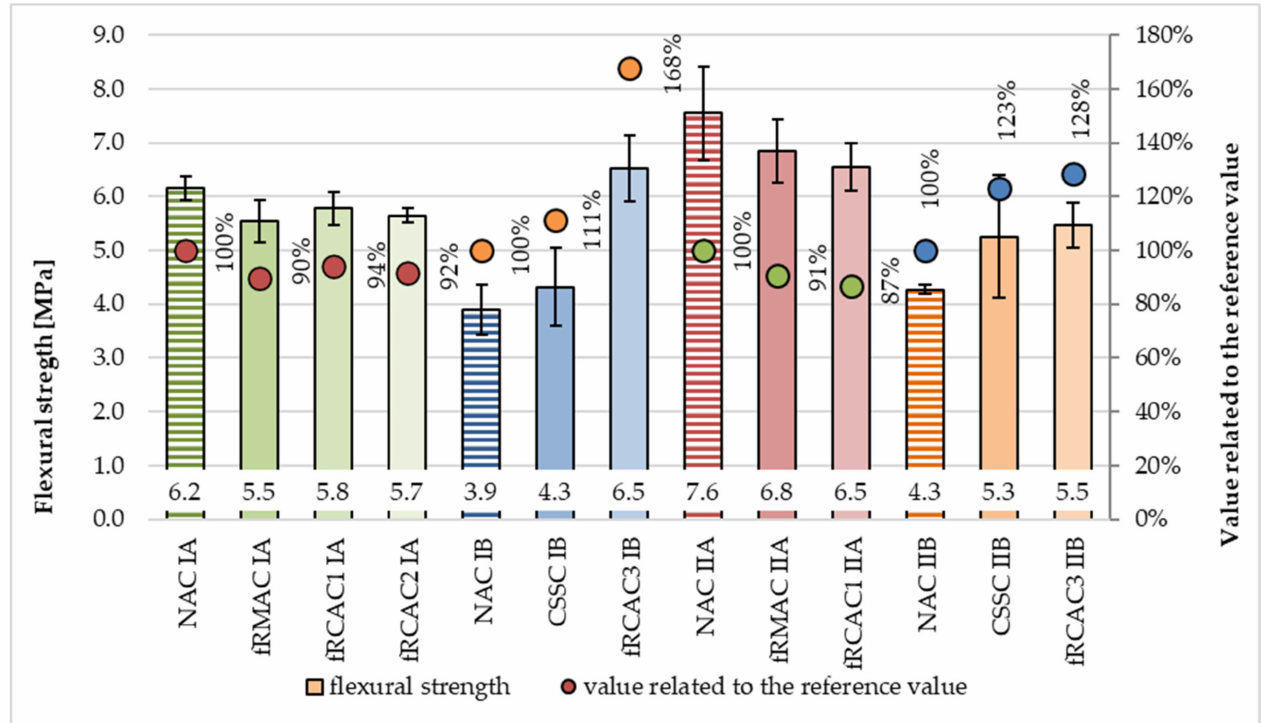
Figure 8. Comparison of flexural strength at age 28 days of concrete containing fNA, fRCA, and fRMA with respect to control